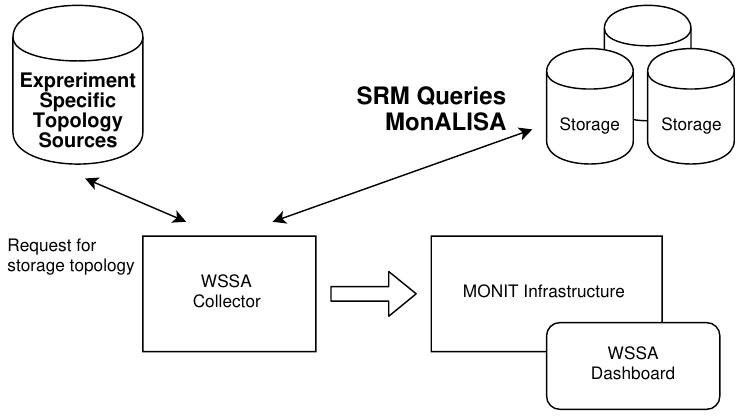
Figure 1. Initial implementation using the technologies available at the time.